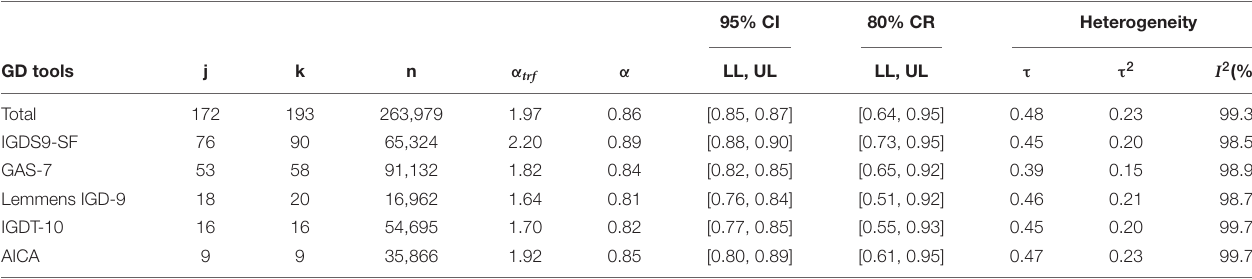
TABLE 2 | Result of reliability statistics for the five GD assessment